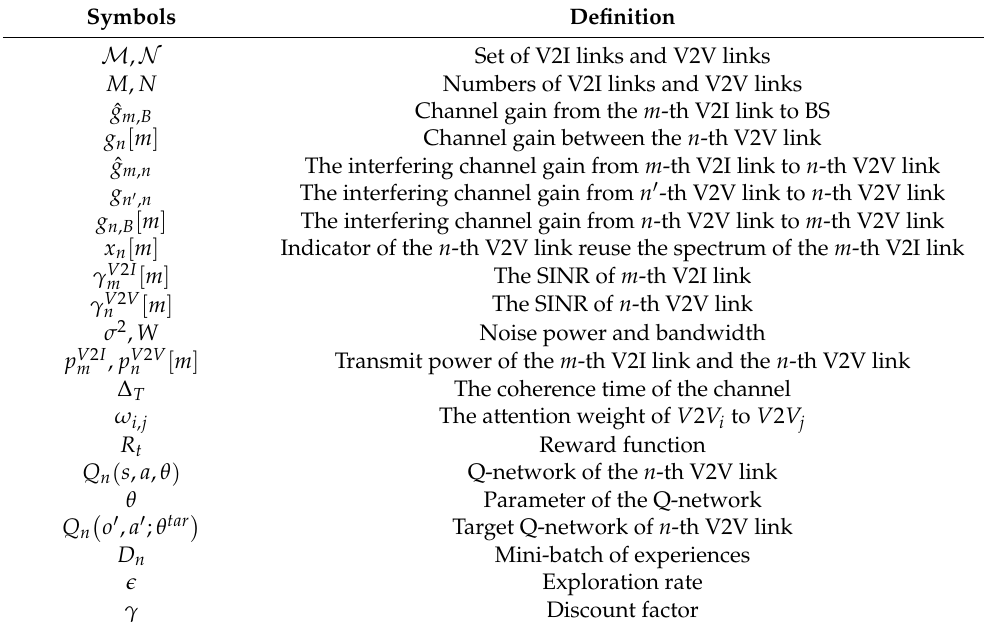
Table 1. Key mathematical symbols.